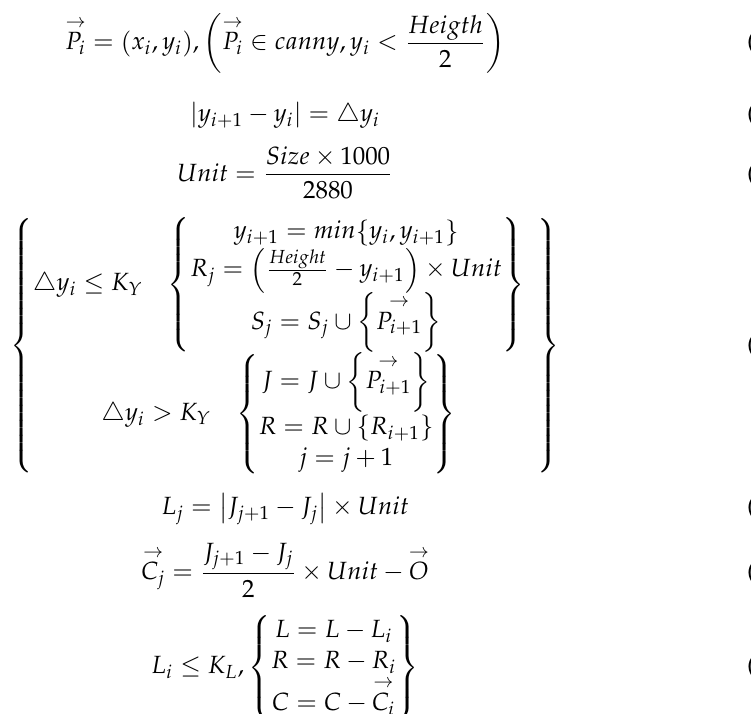
Figure 3. Feature recognition network classification feature. It can be seen from the processing results that the feature contour edge of the top view of the part can be summarized into a multisegmented square wave function. The processing of the contour edge is actually the detection and screening of the discontinuity point of the square wave function and the band with zero or positive infinity slope.